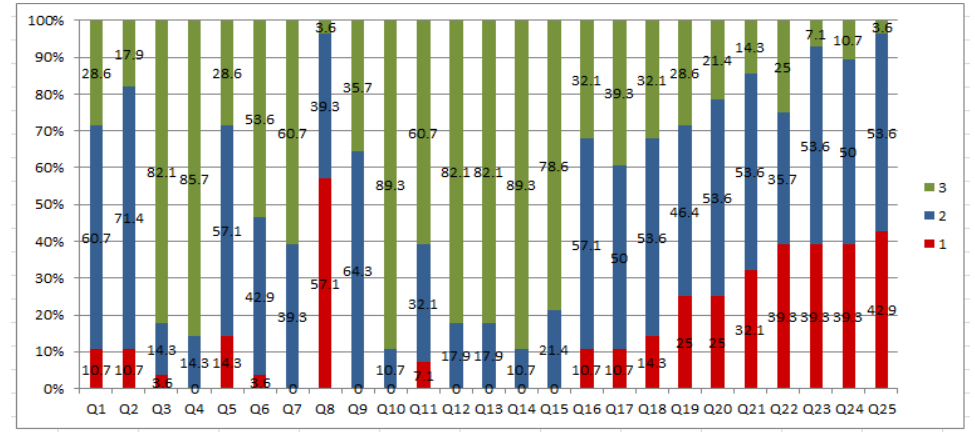
Figure 8. Evaluation of students’ learning outcomes—2017.